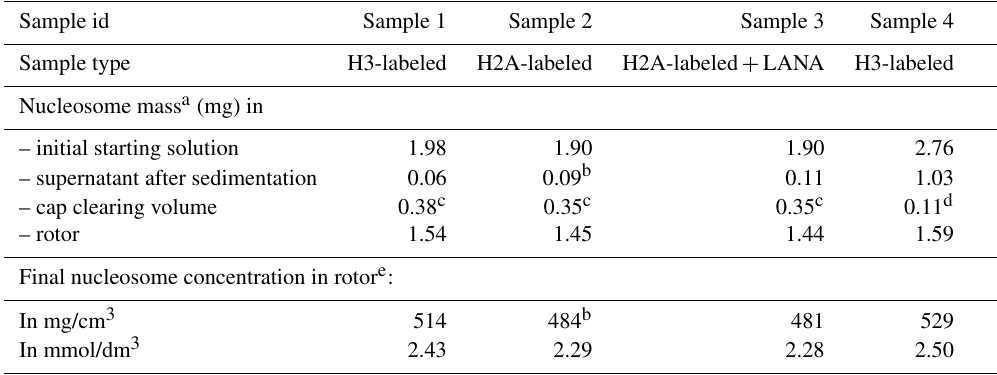
Table 1. Estimated nucleosome concentration in